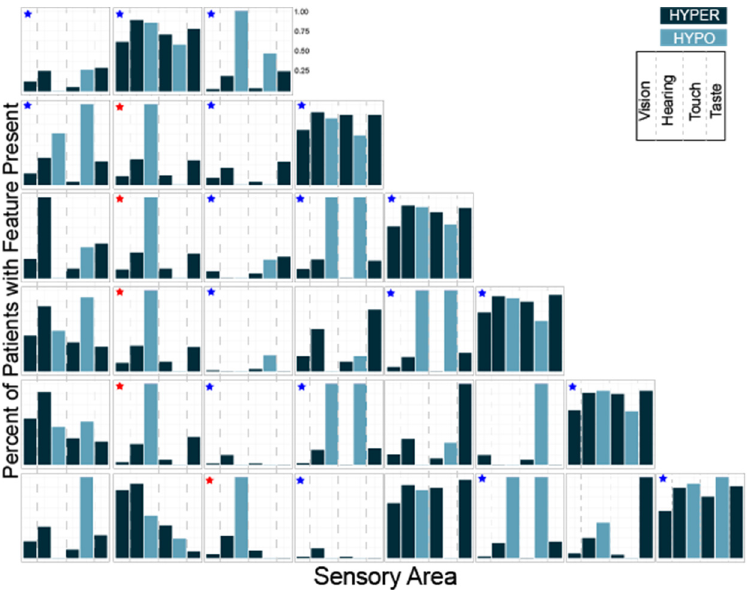
Figure 5. Histograms showing the number of participants with each sensory feature for K = 3 through K = 8 clustering. The three groups present regardless of the total number of clusters are marked with blue stars. Groups characterized by differences in hearing and taste or isolated auditory hyposensitivity are marked with red stars.